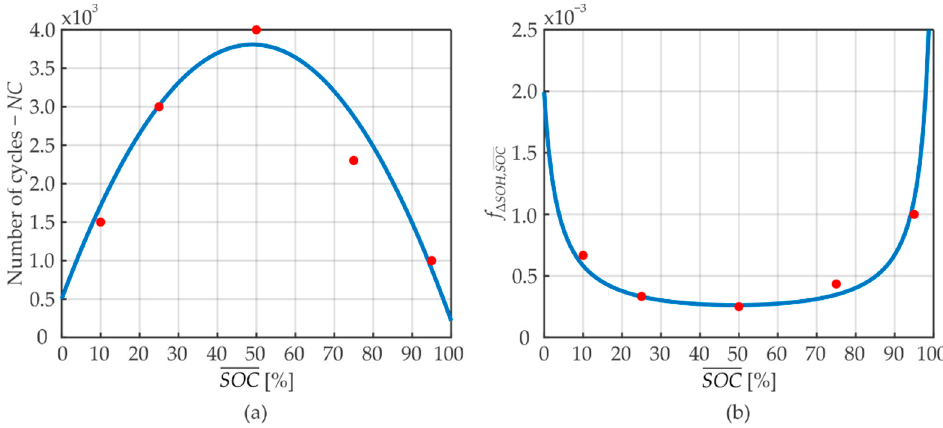
Figure 2. Influence of the average state of charge: ( a ) number of cycles and ( b ) f Δ SOH,SOC . Table 1. Values for tuning coefficients of models of lithium-ion degradation impact